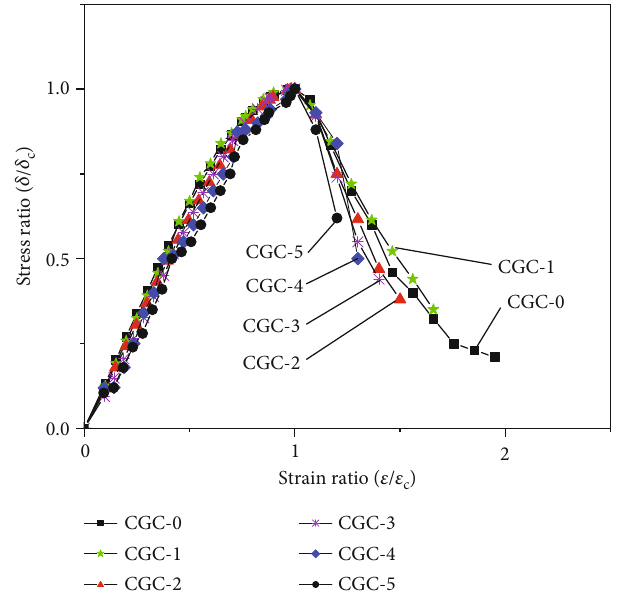
Figure 8: Complete stress-strain curve of concrete.